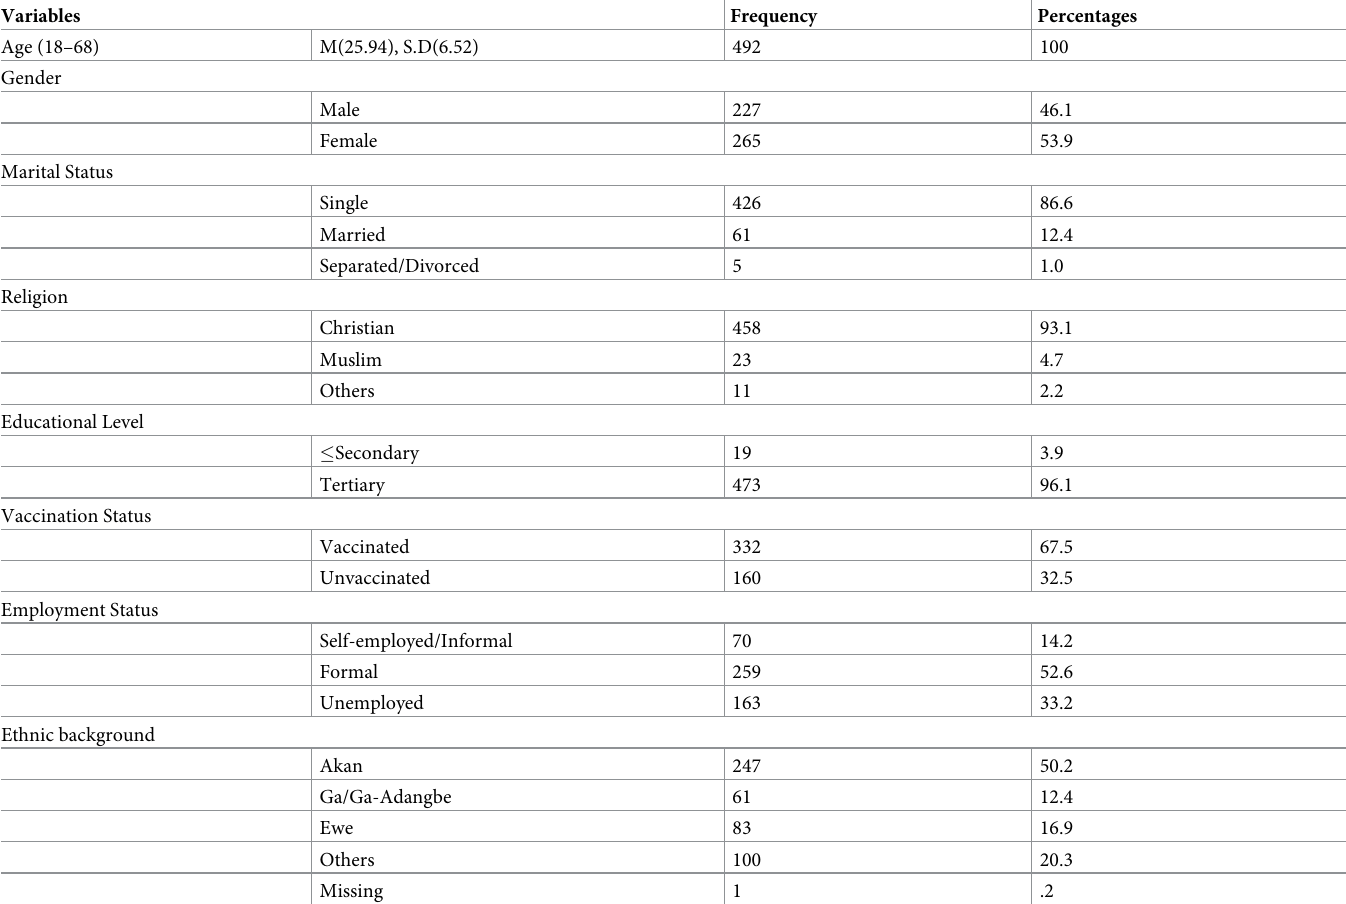
Table 1. Frequency distribution of demographical characteristics (N = 492).